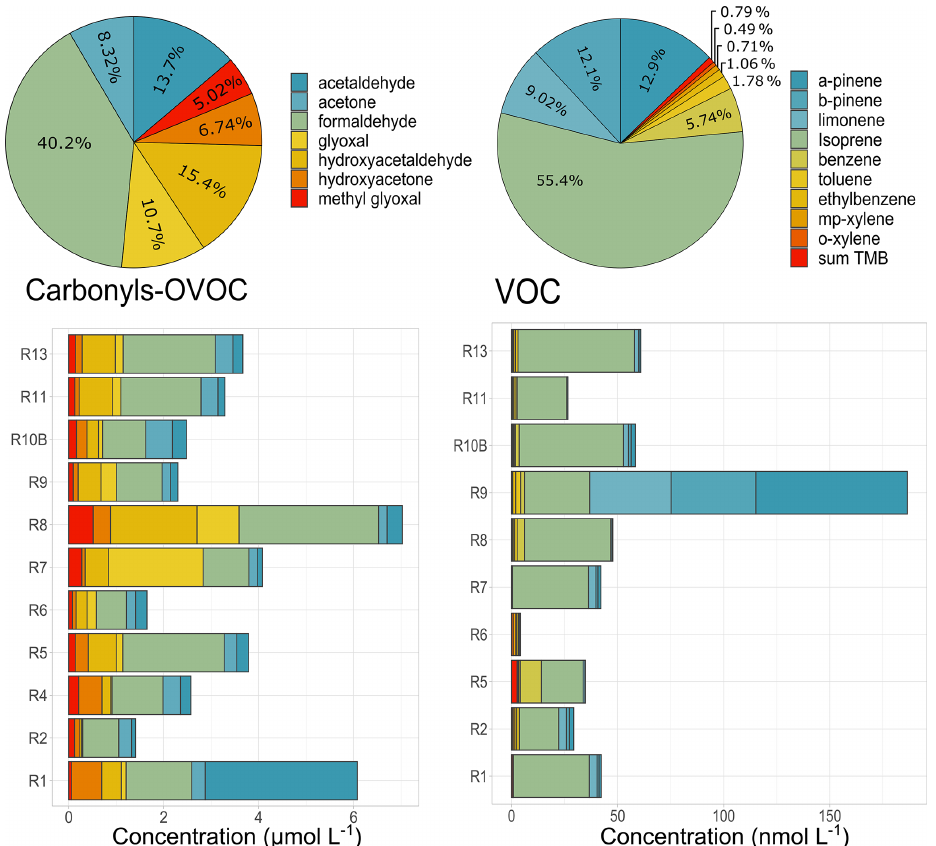
Figure 6. Concentrations and total relative contributions of carbonyls (µmolL − 1 ) and low-solubility VOC (nmolL − 1 ) species observed in cloud waters. Sum TMB represents the sum of 1,2,4-trimethylbenzene, 1,3,5-trimethylbenzene, and 1,2,3-trimethylbenzene concentrations. R1 to R13 refer to individual cloud